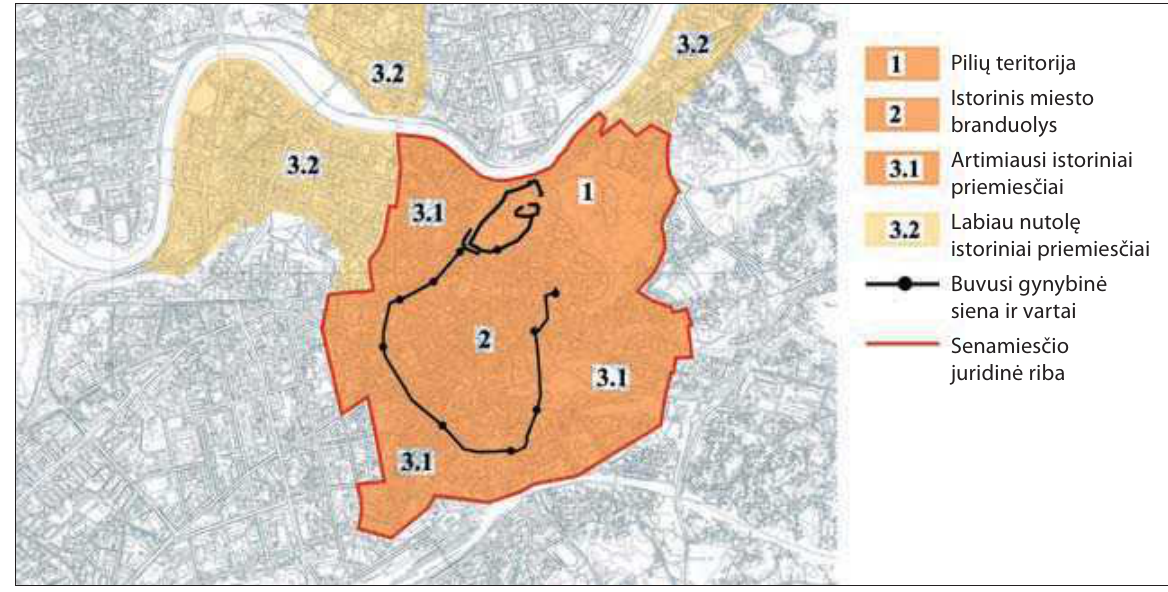
Fig 1. Historic parts of